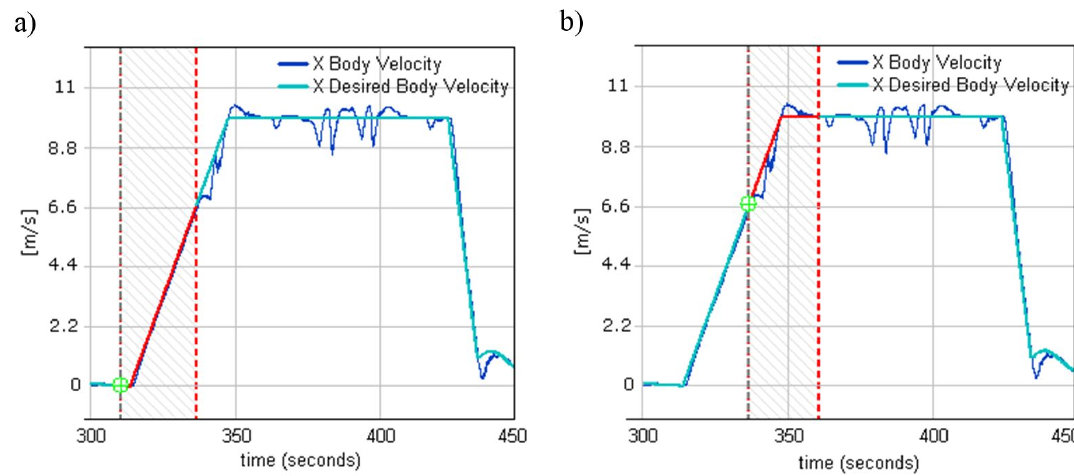
Figure 11. ( a ) X body velocity while approaching the 1st waypoint. ( b ) X body velocity while approaching the 2nd waypoint.